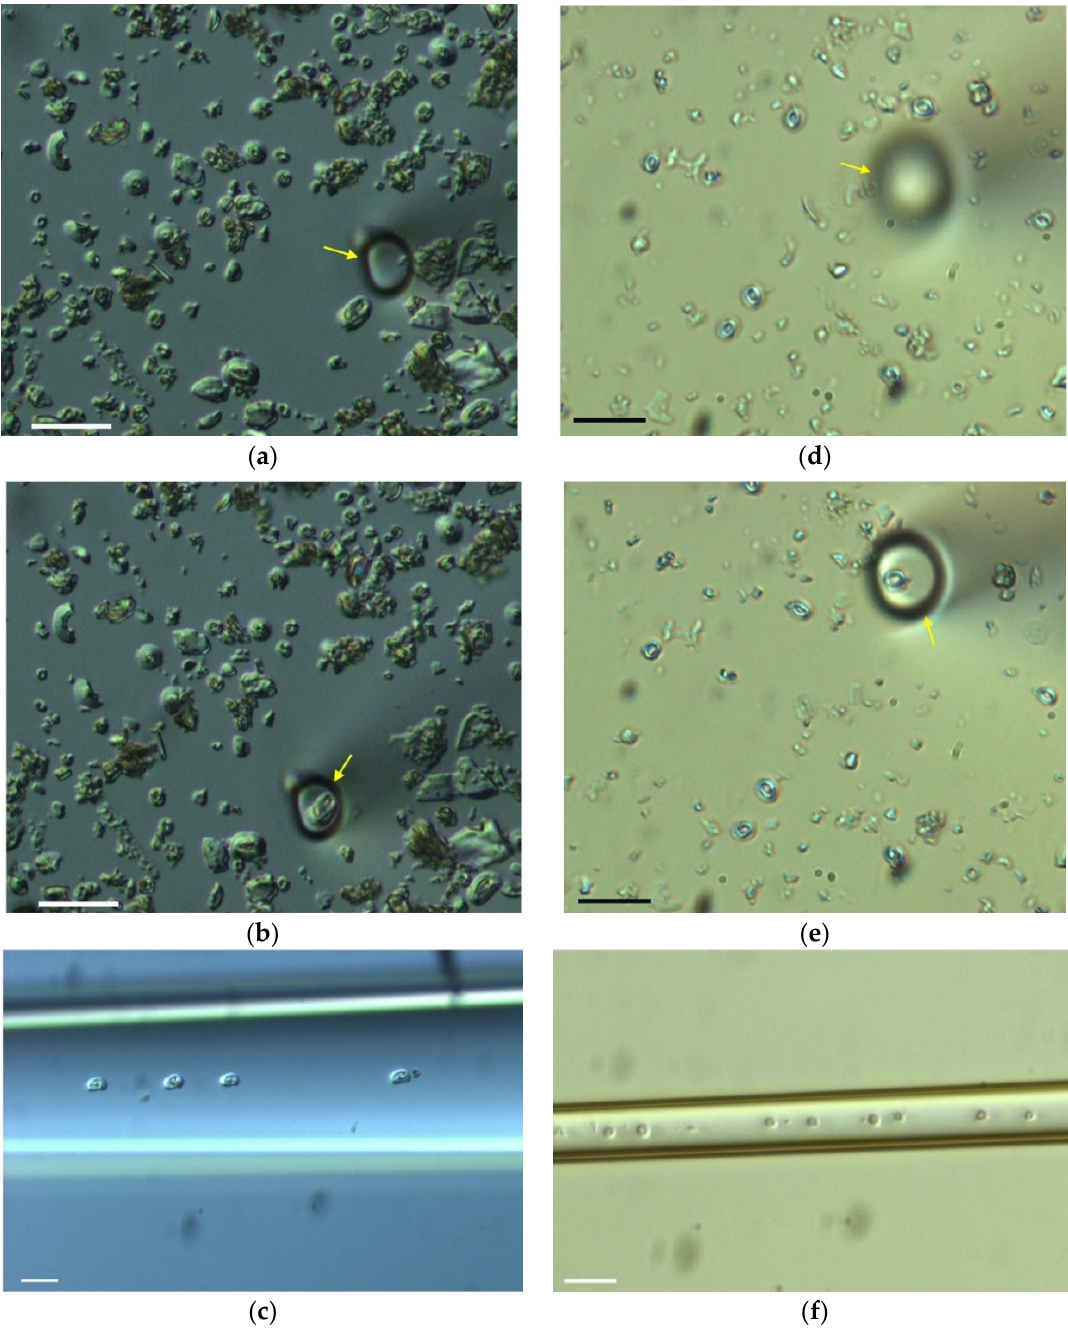
Figure 3. Images of the coccolith capture procedure of two nannofossil species with different size ranges, Helicosphaera carteri and Gephyrocapsa oceanica : ( a ) Microscope view of the selected H. carteri coccolith with a cross section of the capillary (yellow arrow) before the capture moment; ( b ) H. carteri before being aspirated inside the capillary; ( c ) nannofossils of H. carteri retained inside the capillary; ( d – f ) Images of the capture procedure and ( f ) of the nannofossils retained within the capillary for the species G. oceanica . Scale bars are 20 μ m.